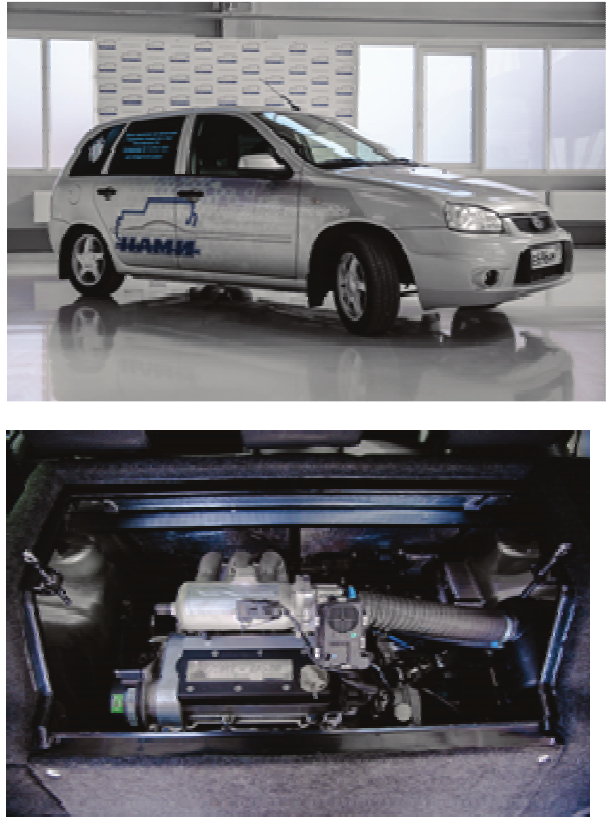
Fig. 3. Hybrid vehicle with Range